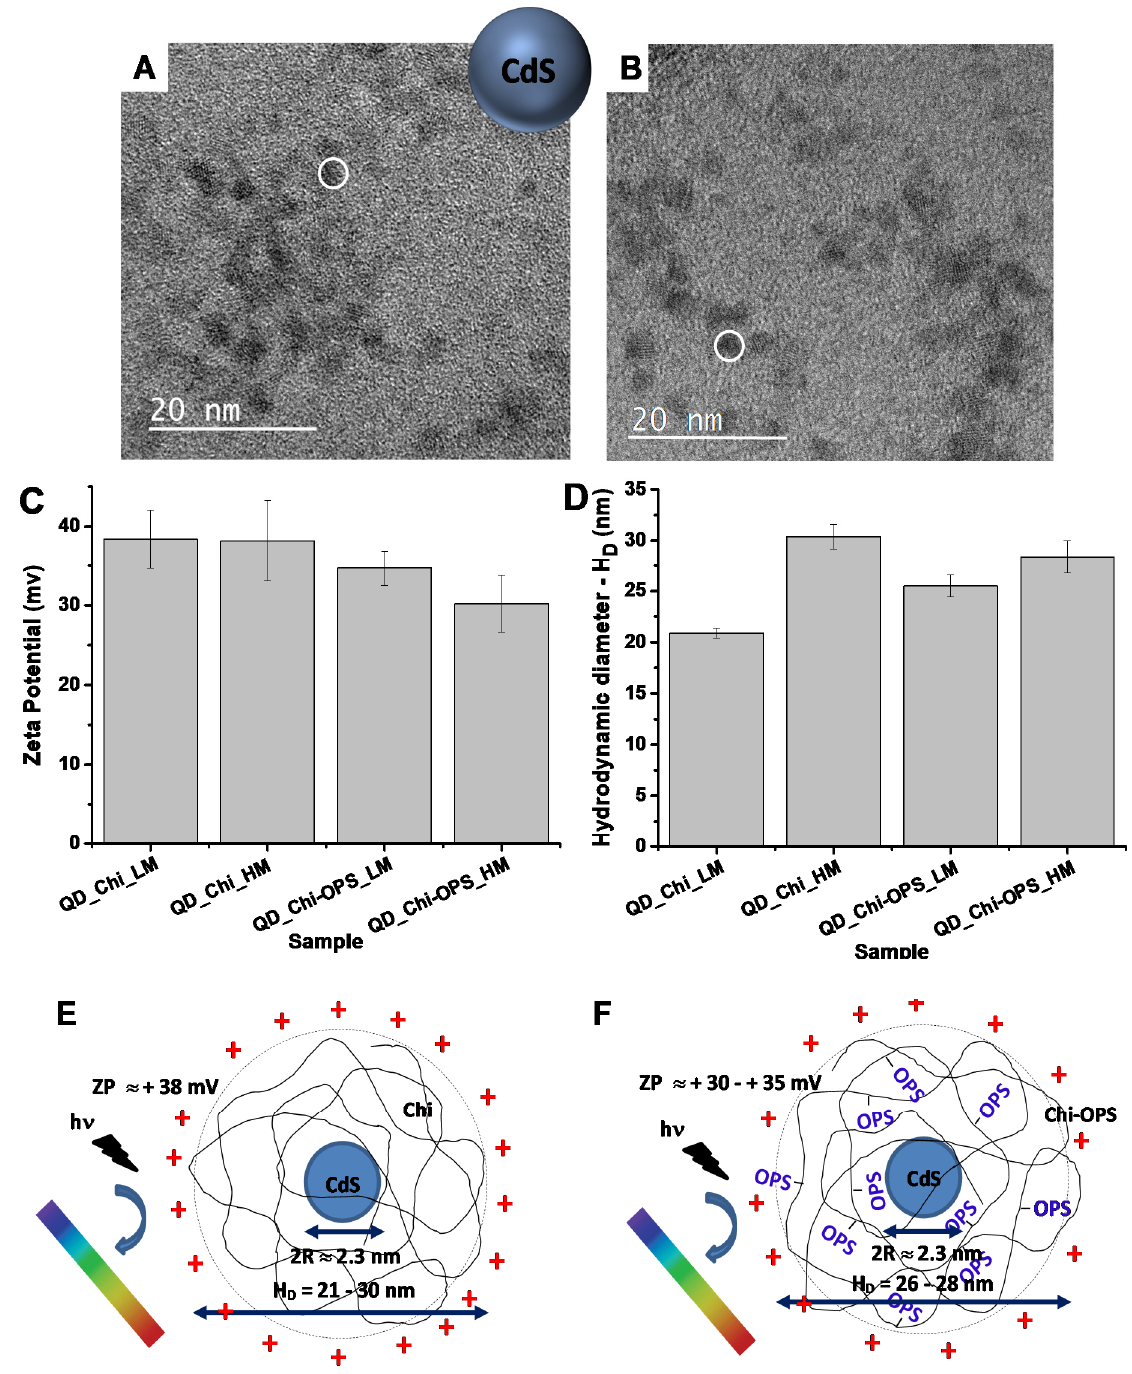
Figure 2. TEM images of QD CdS core (surround by white circle): ( A ) Sample QD_Chi_LM and ( B ) sample QD_Chi- OPS_LM. ( C ) Zeta potential and ( D ) hydrodynamic radius values for Chi and Chi-OPS CdS (LM and HM). Schematic representation of ( E ) QD_Chi and ( F ) QD_Chi-OPS (not to scale).